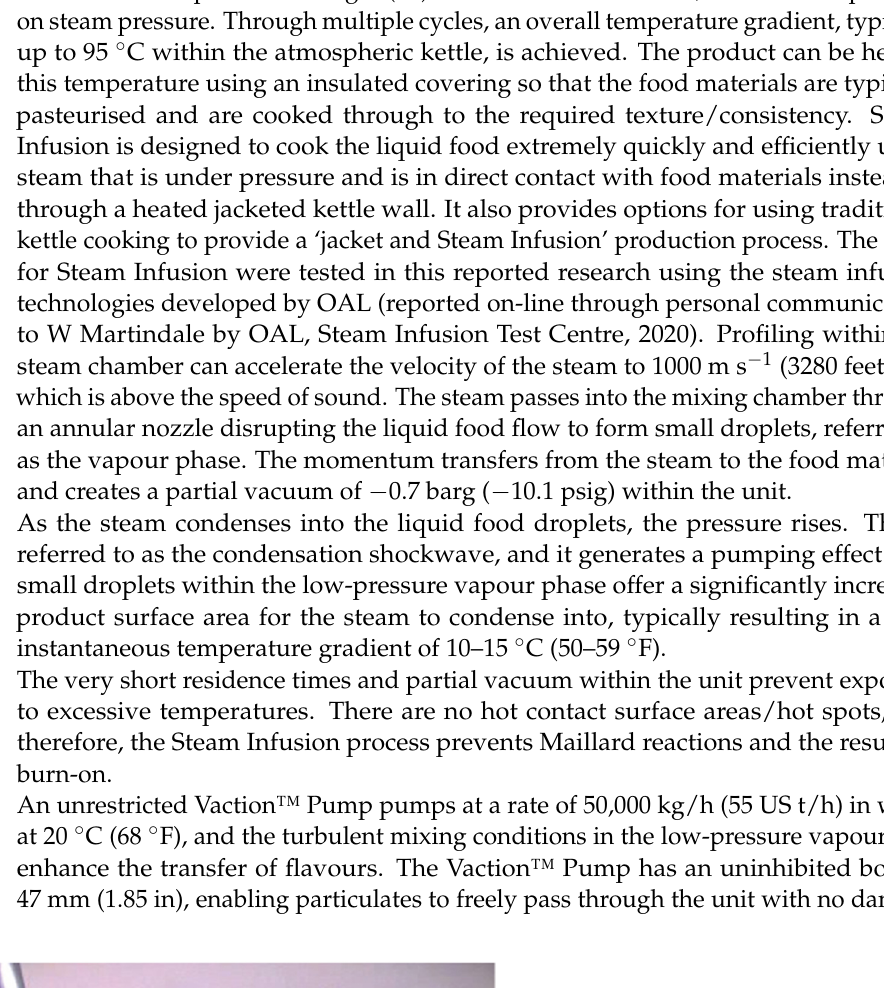
Figure 2. The OAL Steam Infusion Vaction™ pump mounted in a cooking kettle with a scraped surface agitator. Image provided by OAL. 2.3. Analysis of Food Volatiles for Steam Infusion Cooking Batches of a curry sauce produced by conventional steam jacket cooking and by Steam Infusion cooking were compared for different food headspace volatile compound composition using solid phase microextraction (SPME)-gas chromatography (GC)-mass